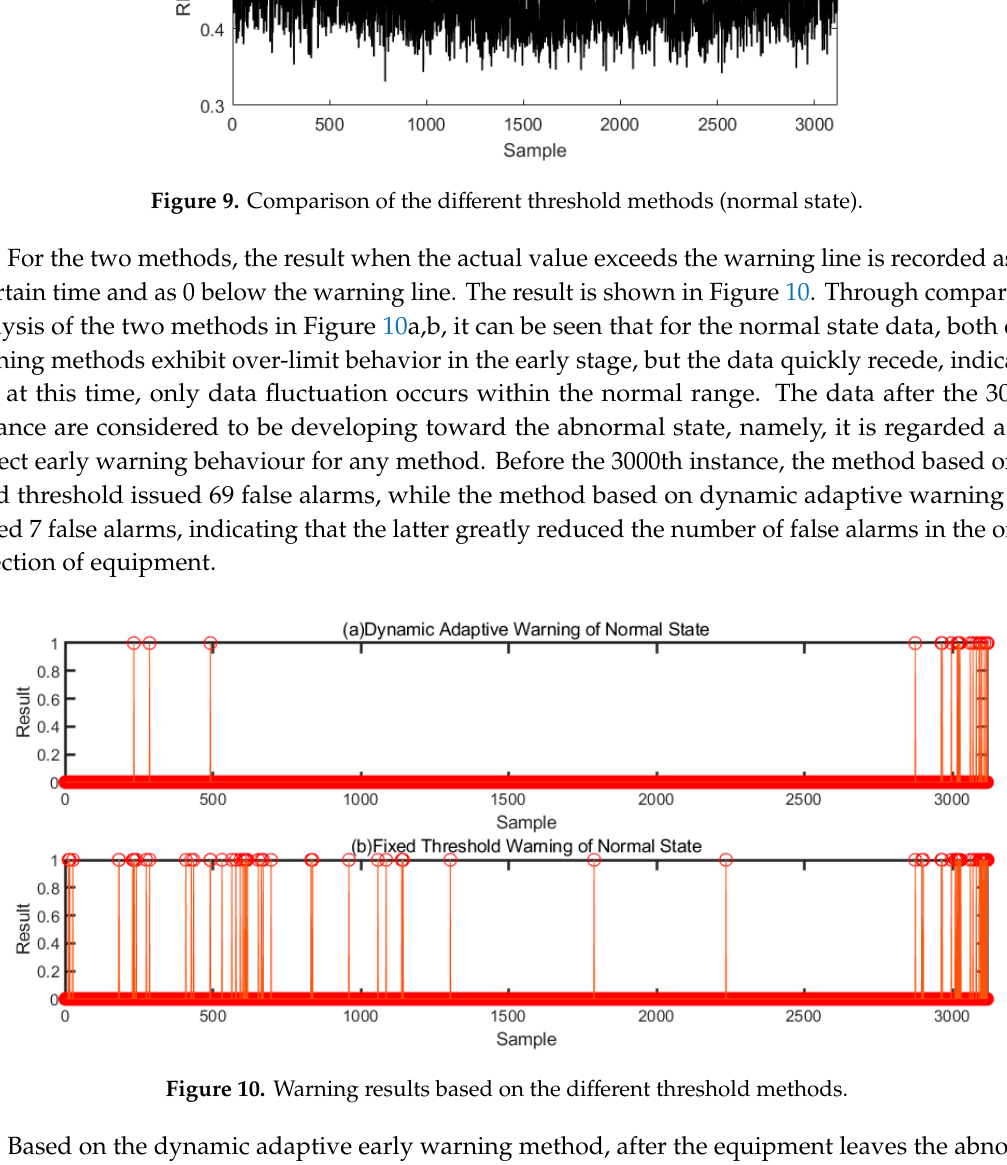
Figure 9. Comparison of the different threshold methods (normal state).